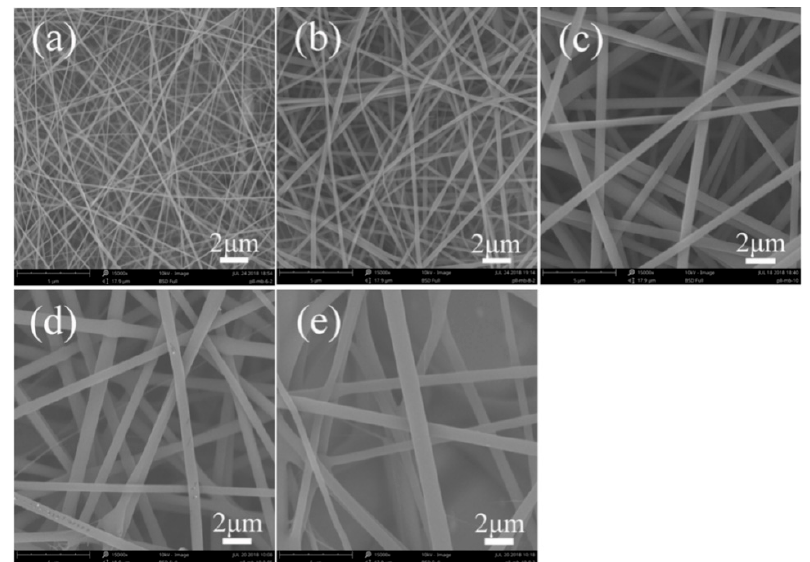
Figure 2. SEM images of fluorescent SF-RB nanofibers with different SF and RB concentration. The concentration of SF was ( a ) 6.0 wt%, ( b ) 8.0 wt%, ( c – e ) 10.0 wt%. The concentration of RB was ( a – c ) 1.0 wt%, ( d ) 0.5 wt%, and ( e ) 2.0 wt%, respectively.